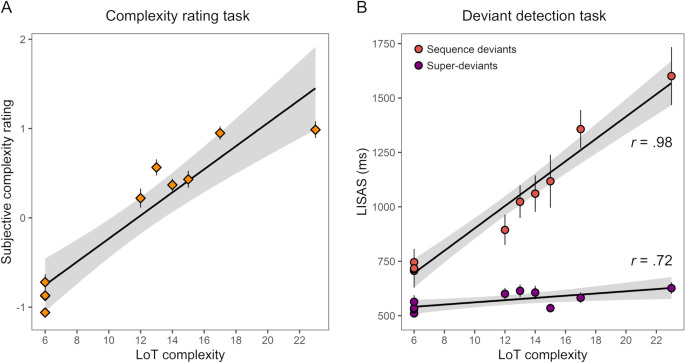
Linear relationship between LoT complexity and subjective and objective measures obtained in experiment 1 with ten 16-items long auditory sequences (with 95% confidence intervals bands in gray).The Pearson correlation coefficient (r) is indicated. Each marker represents the group-average for a given sequence. Error bars represent SEM across participants. (A) LoT complexity vs. subjective complexity ratings. (B) LoT complexity vs. performance in the violation detection task (Linear Integrated Speed-Accuracy Score), for sequence deviants and super-deviants.